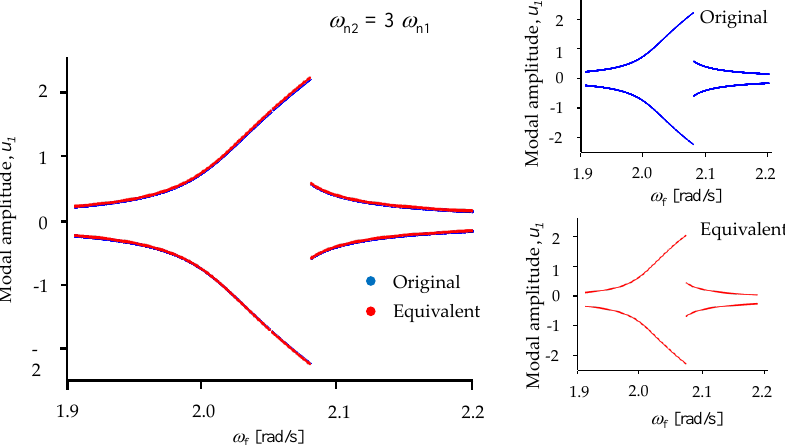
Figure 15. Bifurcation diagrams computed from the numerical integration solutions of Equations (29) and (43). The parameter values used to obtain these curves were 𝑚 1 = 10 kg, 𝑚 2 = 0.6 kg, 𝑐 1 = 0.1 Ns/m, 𝑐 2 = 0.08 Ns/m, 𝑘 1 = 44 N/m, 𝑘 2 = 8 N/m 3 , 𝑘 3 = 20.828 N/m, 𝑘 4 = −0.65 N/m 3 , and 𝑓 0 = 0.37 N, with 𝜔 𝑛2 = 3𝜔 𝑛1 . Here, the black line represents the bifurcation diagram computed from the numerical integration solutions of Equation (43), while the red line describes the one obtained from Equation (29).